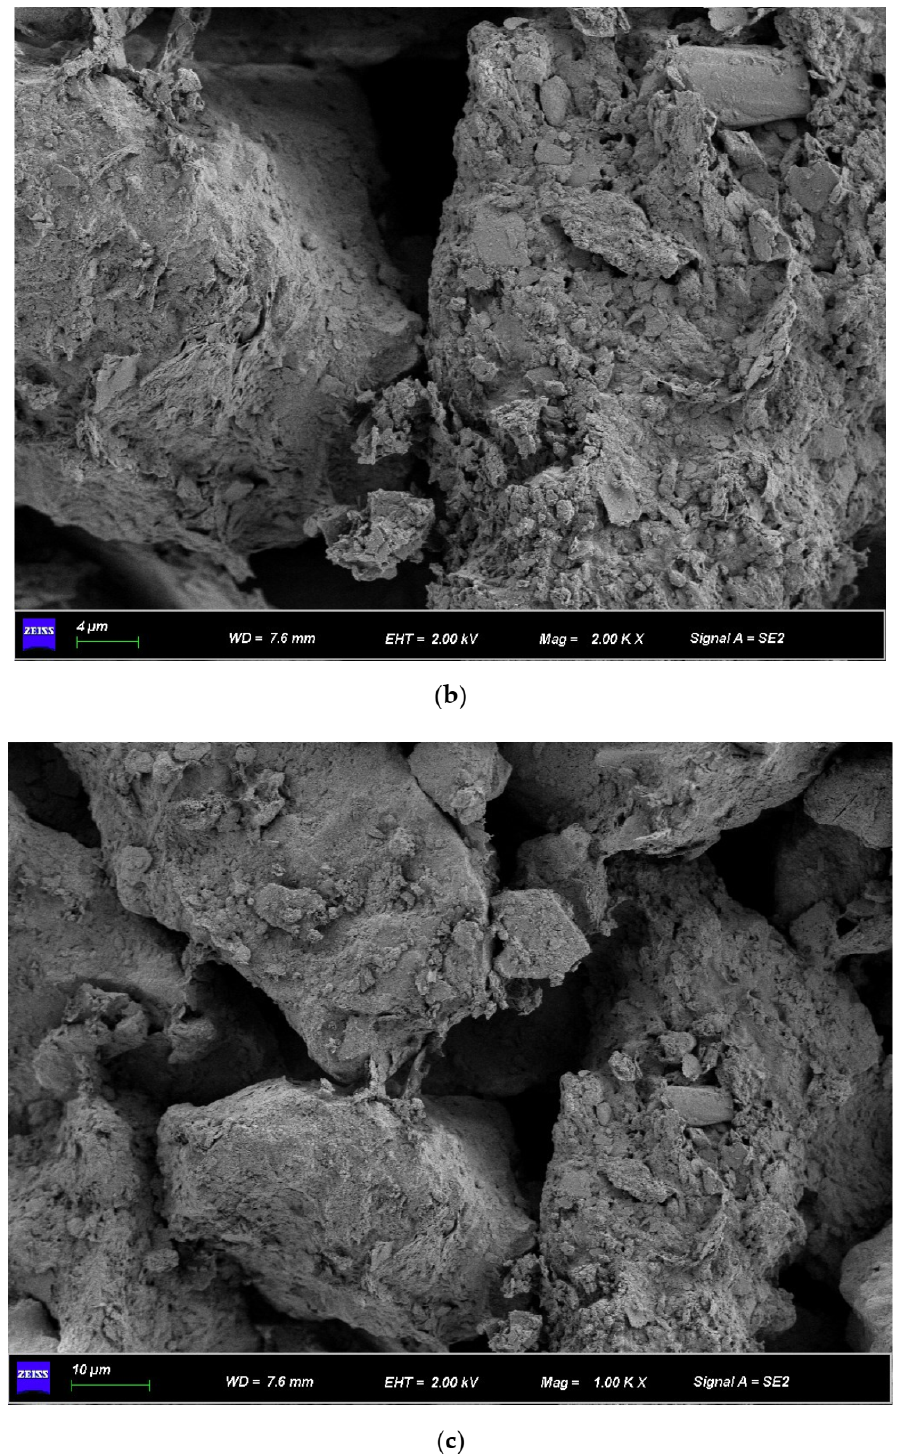
Figure 10. SEM micrographs of D1 at different magnifications. ( a ) 2 µ m; ( b ) 4 µ m; ( c ) 10 µ